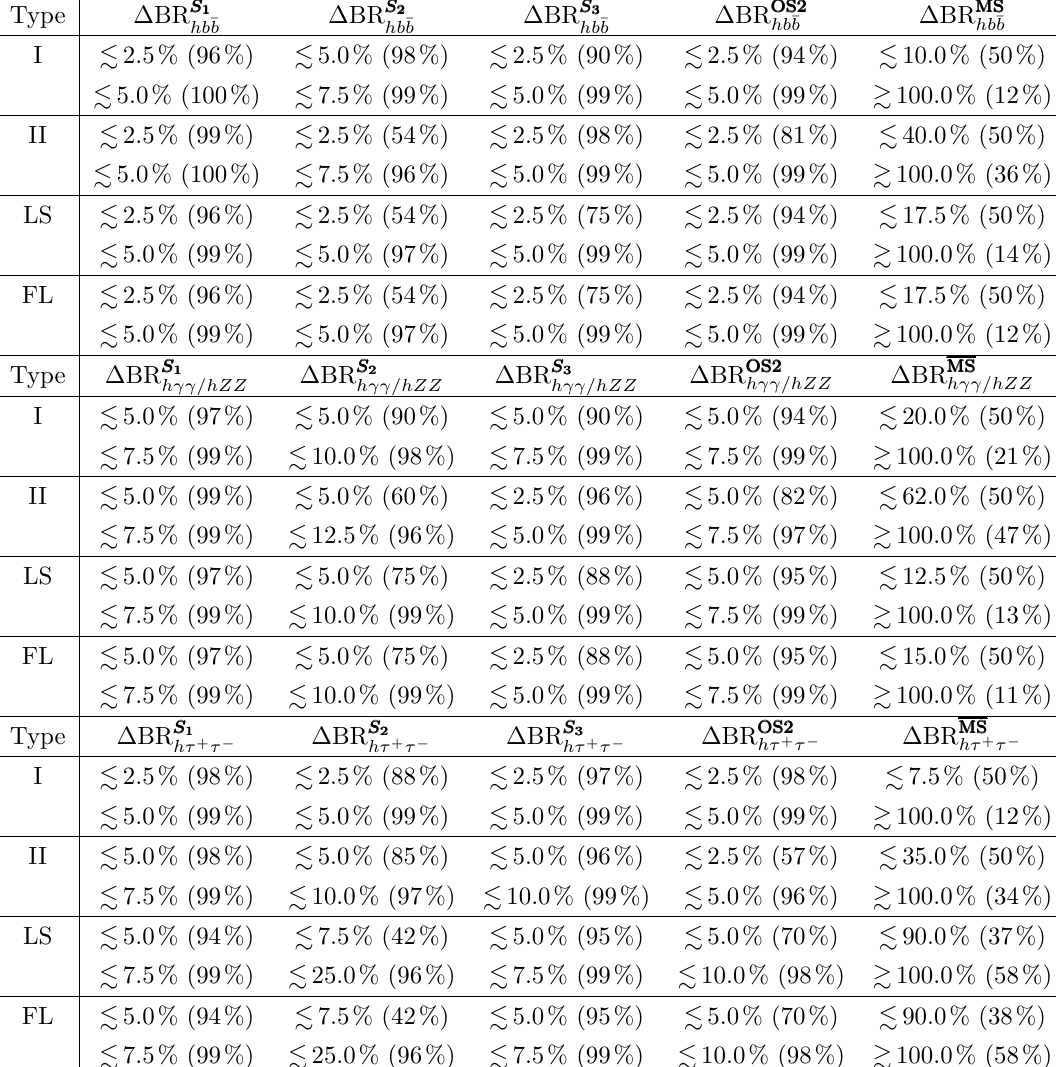
Table 5 . Relative size of the EW corrections to the BRs of the 2HDM SM-like Higgs boson h in the four 2HDM types I, II, LS and FL. For details, we refer to the text.